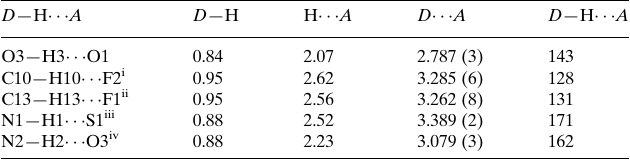
Hydrogen-bond geometry (A˚ , (cid:2)